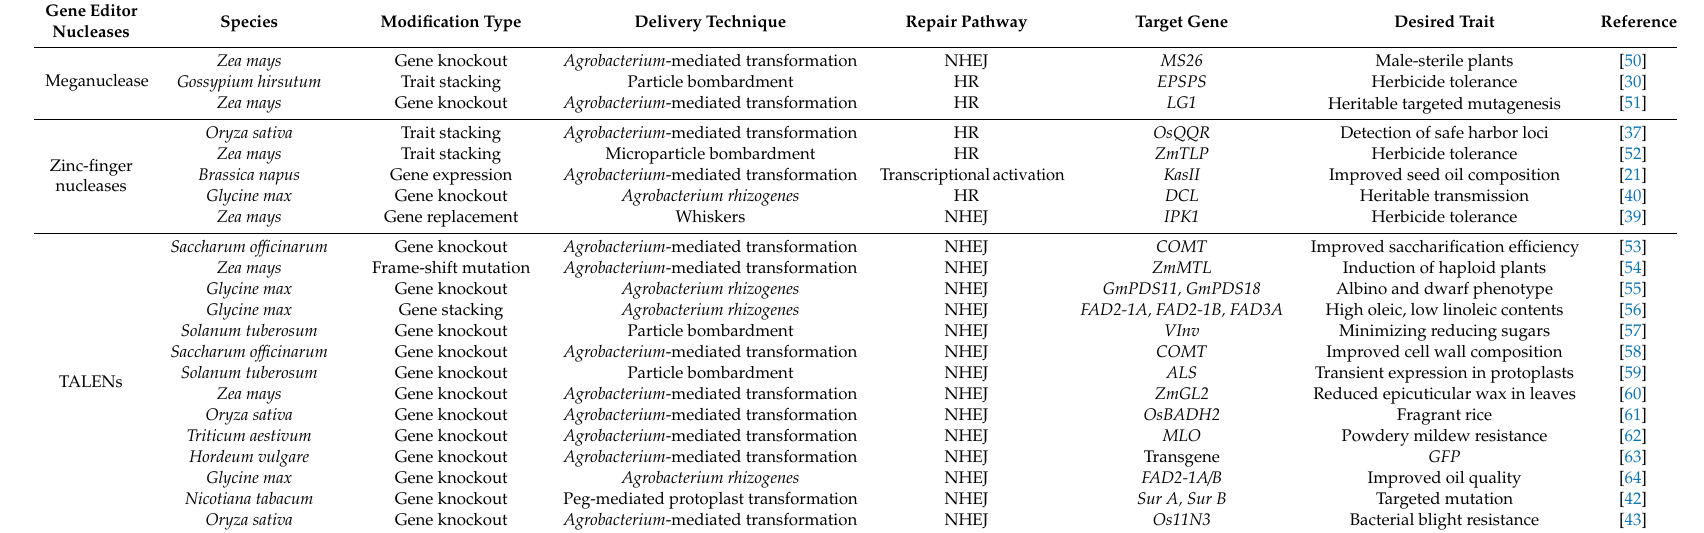
Table 1. Applications of first-generation genome editing tools in crop